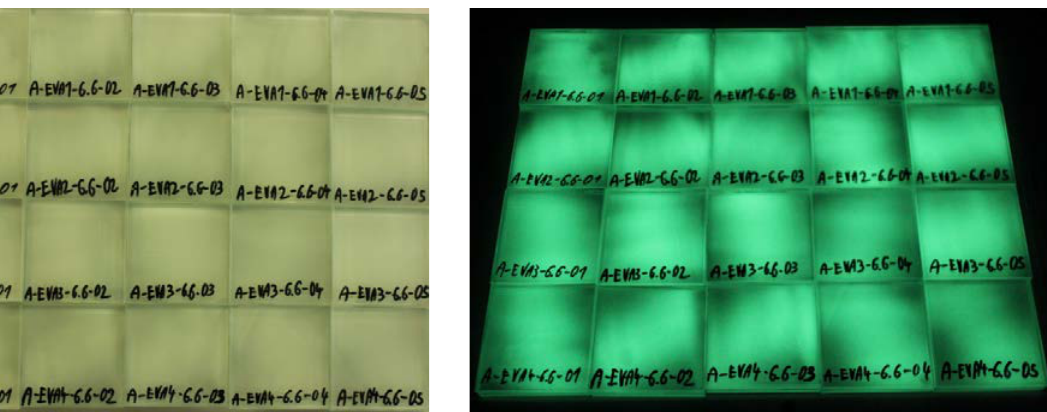
Fig. 26 Samples in white light Fig. 27 Samples in